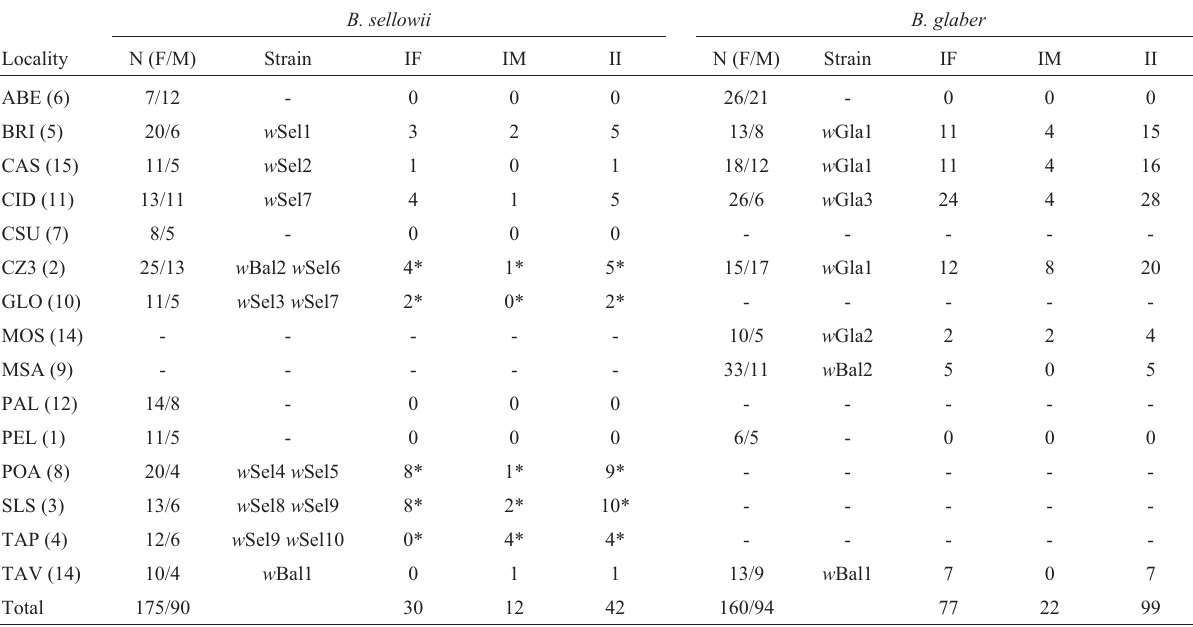
Table 1 - Prevalence of Wolbachia in B. sellowii and B. glaber